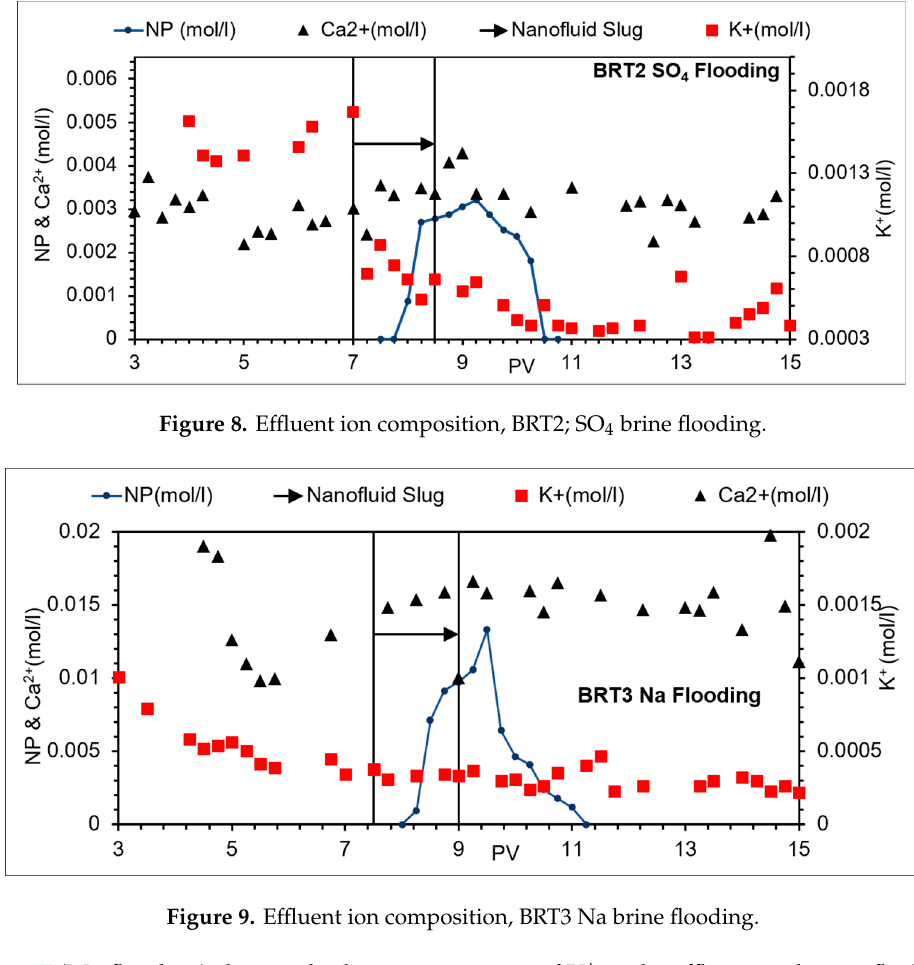
Figure 9. Effluent ion composition, BRT3 Na brine flooding.